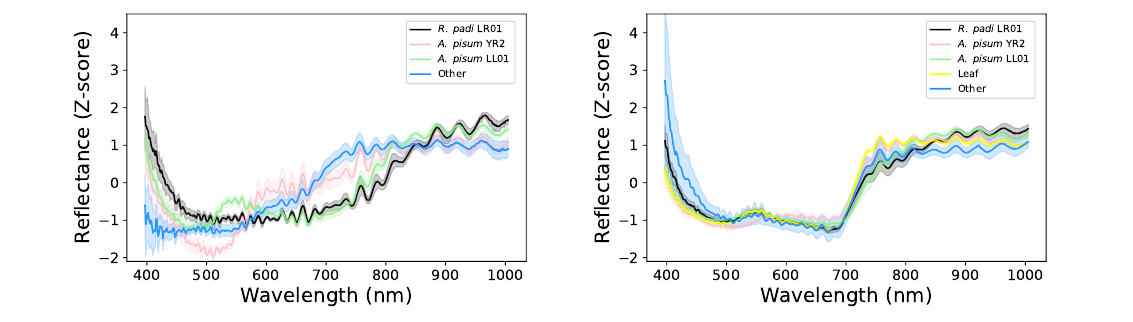
Figure 6. Z-score standardized average light reflectance spectra of the three aphid lines, including all aphid stages. Aphid spectral signatures are different between lines and seem to overlap with leaf spectral signatures.